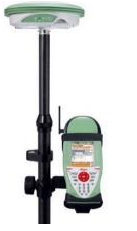
Figure 2. GNSS receiver GPS viva G08 plus by Leica